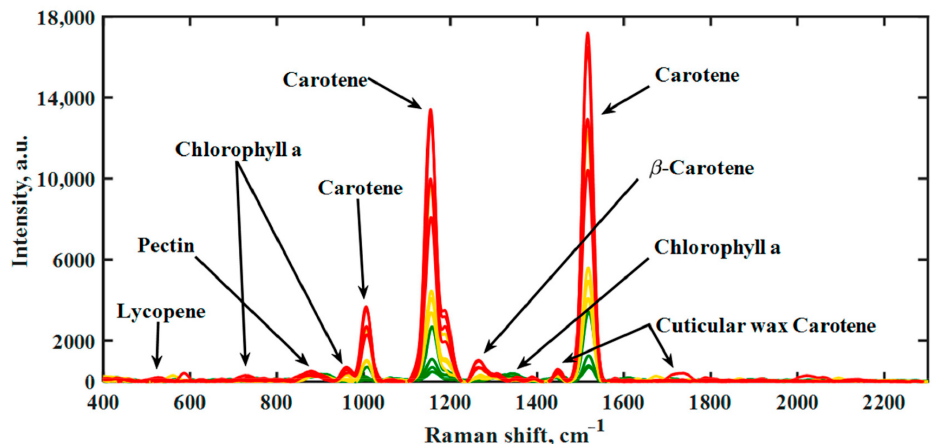
Figure 4. Raman spectra of hot peppers during the maturation process obtained with handheld Raman spectrometer at 785 nm laser wavelength with a power of 100 mW. Unripe pepper (green), ripening pepper (yellow), and fully ripe fruit (red) are each represented by four deliberately selected spectra. Copyright MDPI